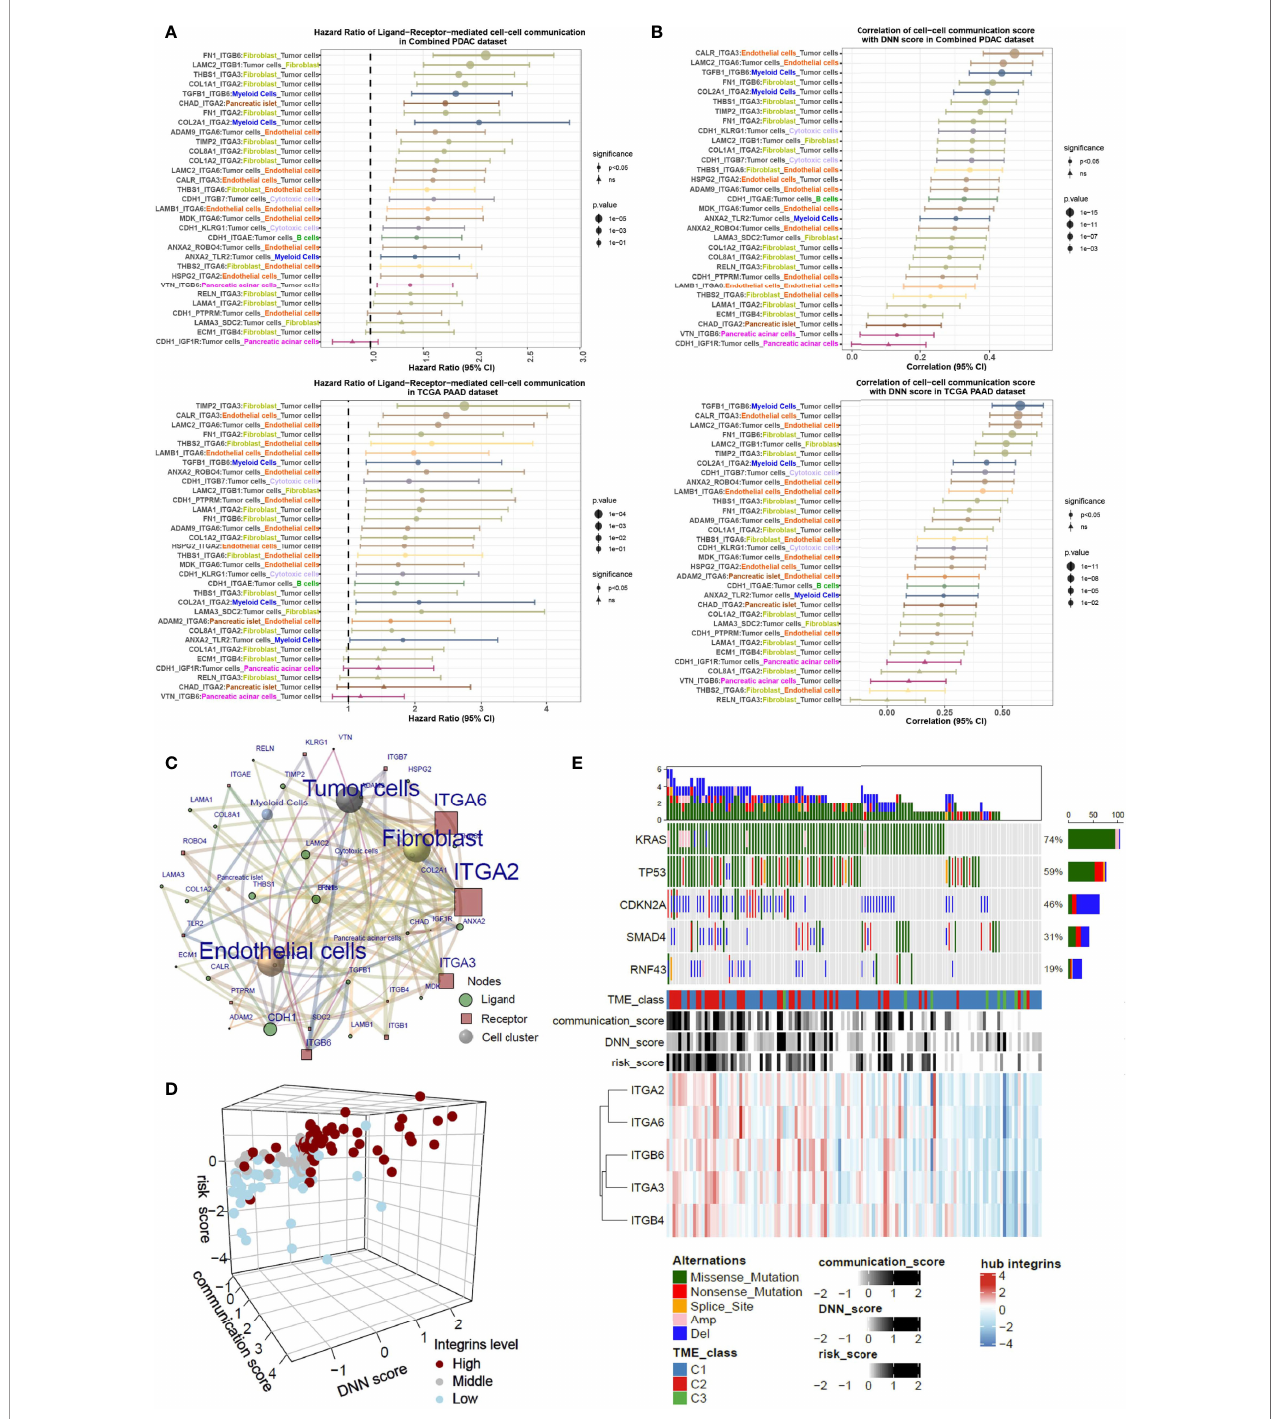
FIGURE 6 | Integrins are key mediators critical for tumor cell- fi broblast and tumor cell-endothelial cell communications. (A) The HRs of cell – cell communication scores of PDAC patients in both the combined PDAC dataset and TCGA dataset, analyzed by the Cox regression model. (B) Correlation of the cell – cell communication score with DNN scores in both combined PDAC and TCGA datasets. Forest plots show the correlation coef fi cients together with the 95% con fi dence intervals. (C) A sending cell – ligand – receptor – target cell network shows the key contributors within it. The notes and edges are weighted by the integrated HR in combined PDAC and TCGA datasets. The result indicates that integrin-mediated tumor cell – fi broblast and tumor cell – endothelial cell communications are dominant in the network. (D) Three- dimensional plot shows the relationships with the cell – cell communication score, DNN score, risk score, and expression levels of integrins. (E) Water fl ow plot indicates the enrichment of genetic variations in pancreatic cancers with high levels of cell – cell